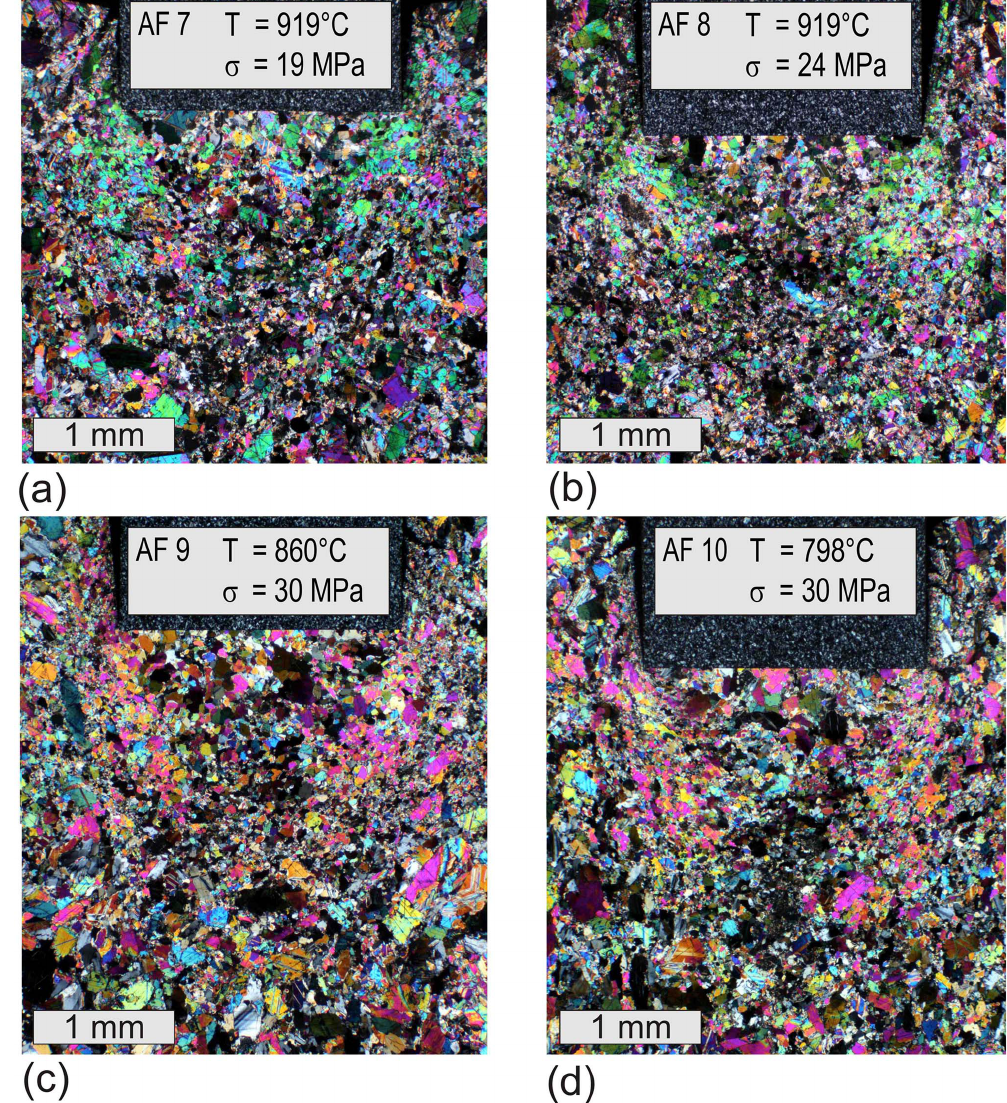
Figure 10. Optical micrographs showing anhydrite microstructures developed beneath the indenter for experiments at different temperatures and reference stresses: (a) AF 7: 919 ◦ C, 19MPa; (b) AF 8: 919 ◦ C, 24MPa; (c) AF 9: 860 ◦ C, 30MPa; (d) AF 10: 798 ◦ C, 30MPa (see Table 1 for details). Modification of microstructure and development of CPO related to indentation in deformation zone mantling undeformed central cone (Fig. 9c) is well